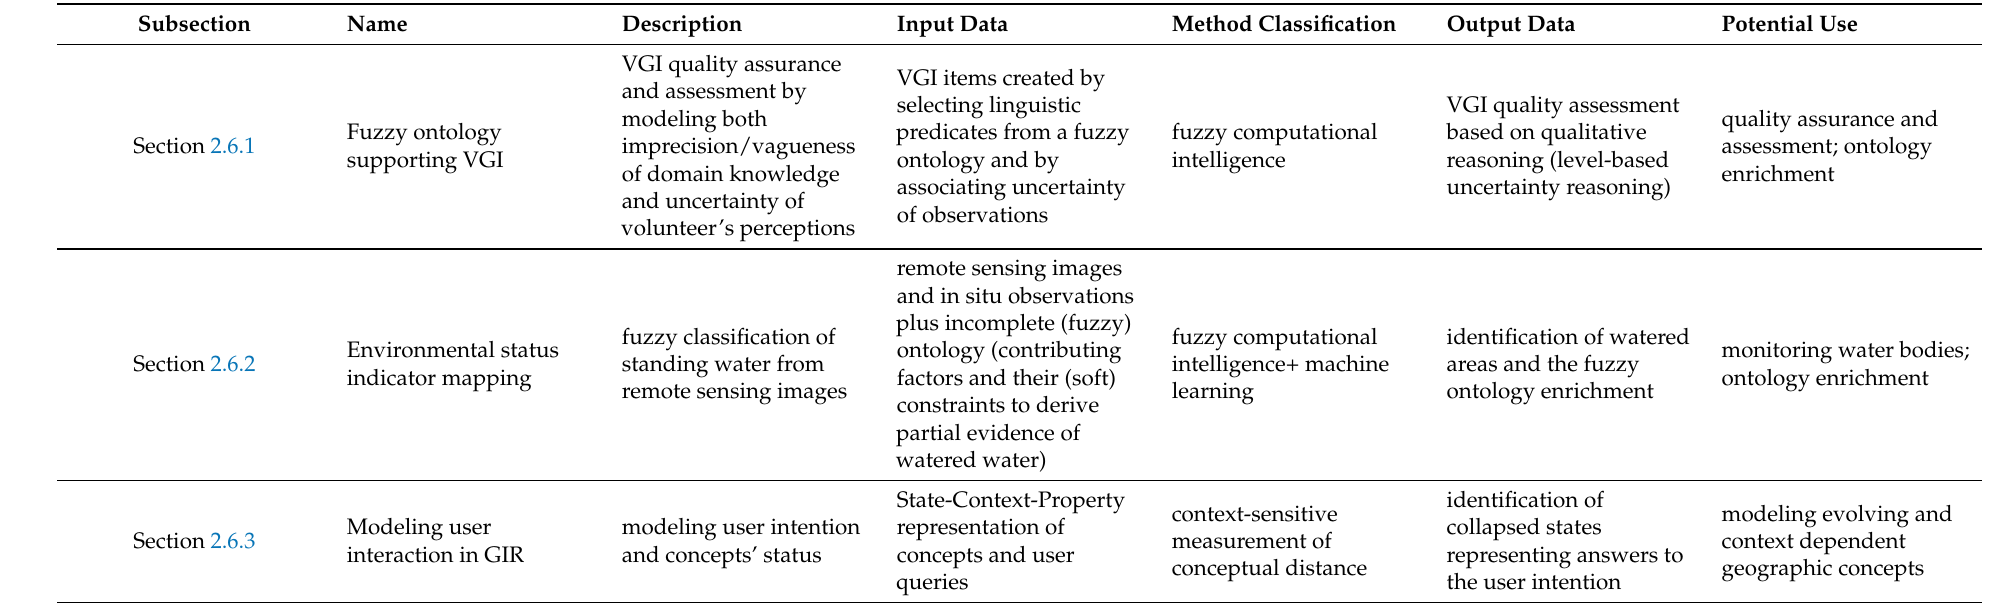
Table 3. Dimensions of case studies (Powerful